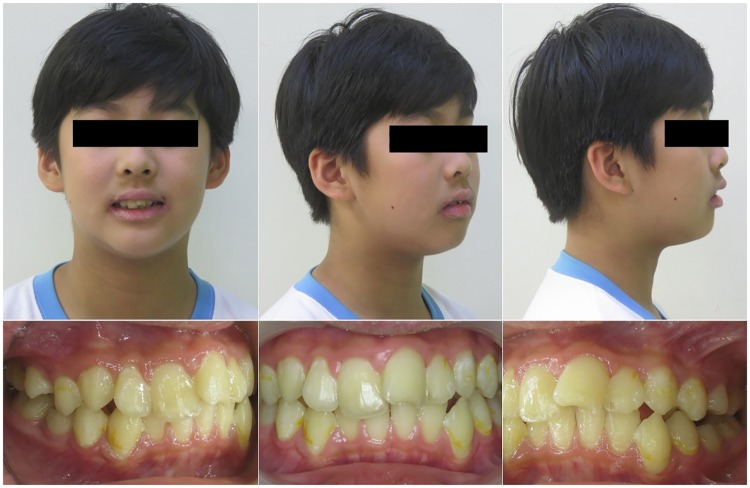
A 13-year-old boy with a history of allergic rhinitis (AR) suffered dental trauma injury at the left maxillary incisor due to sport accident.The profile shows lip incompetence, a weak lip, and an acute nasal labial angle. The oral finding was Angle class II malocclusion with a large overjet and proclinating incisors. Consent to publication was obtained form the parents of the patient (S1 File.)